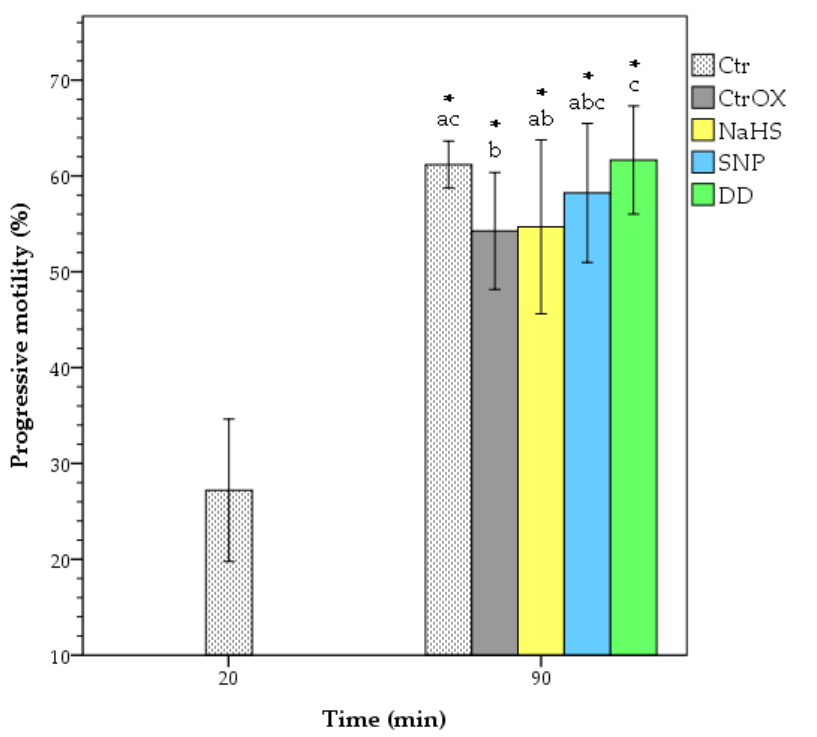
Figure 1. Progressive motility of boar spermatozoa under oxidative stress. Spermatozoa with straightness ≥ 80% were selected as progressive. Different letters indicate significant differences ( p < 0.05) among treatments at 90 min of incubation. The asterisks indicate significant differences ( p < 0.05) of samples compared to Ctr at 20 min of incubation. CTR = control; CtrOX = control under oxidative stress; NaHS = 100 nM; SNP = 100 nM; DD = SNP 100 nM + NaHS 100 nM. Data are shown as mean ± SD of 6 replicates.